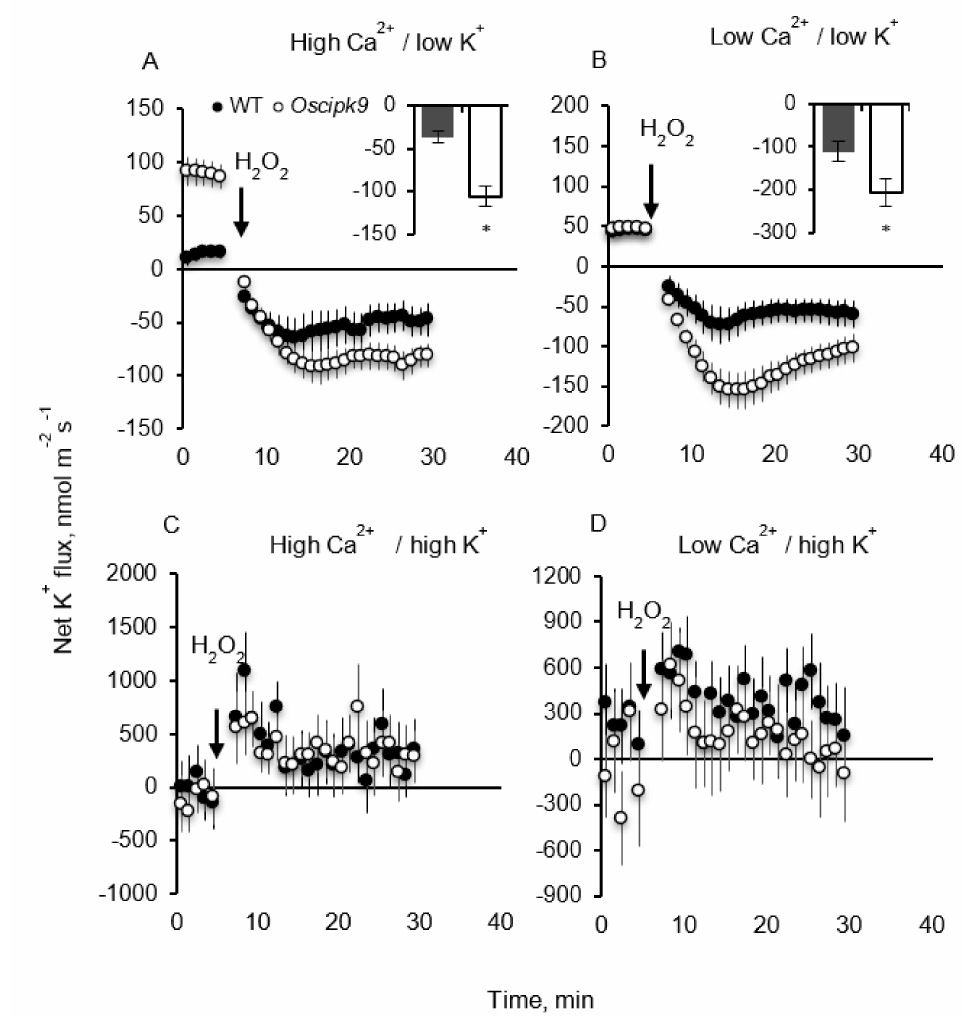
Figure 6. Effect of K + and Ca 2+ availability on kinetics of ROS-induced net K + efflux measured from epidermal mature root cells of Oscipk9 mutant and its WT. ROS stress was imposed by adding 5 mM H 2 O 2 to 5–6-day-old seedlings. ( A ) high Ca/low K (1.5 mM/0.1 mM) conditions; ( B ) low Ca/low K (0.1 mM/0.1 mM) conditions; ( C ) high Ca/high K (1.5 mM/10 mM) conditions; and ( D ) low Ca/high K (0.1 mM/10 mM) conditions. Data are the mean ± SE ( n = 6). The sign convention is “efflux negative”. The inserts in the top two panels depict the magnitude of responses in each line. Open symbols- Oscipk9 ; closed symbols-WT. Asterisk denotes significant difference between WT and cipk9 plants at p <